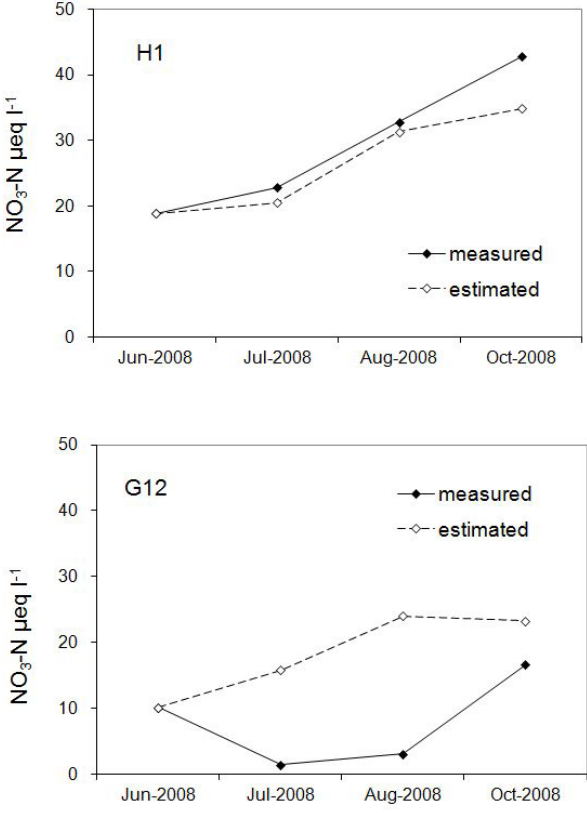
Fig. 4. Measured and estimated (without biological retention) NO 3 concentrations at H1 and G12 sites from June to October